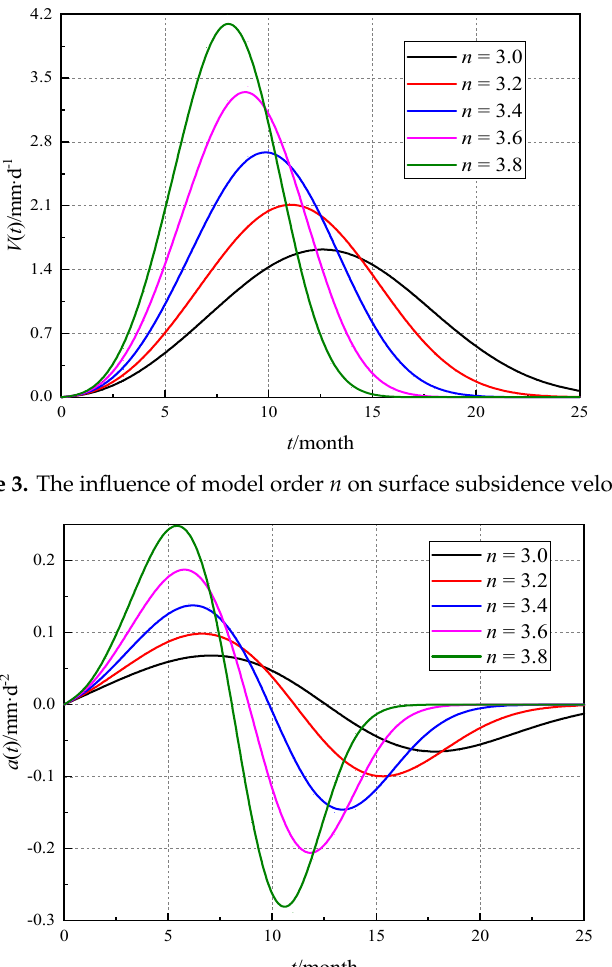
Figure 4. The influence of model order n on surface subsidence acceleration.